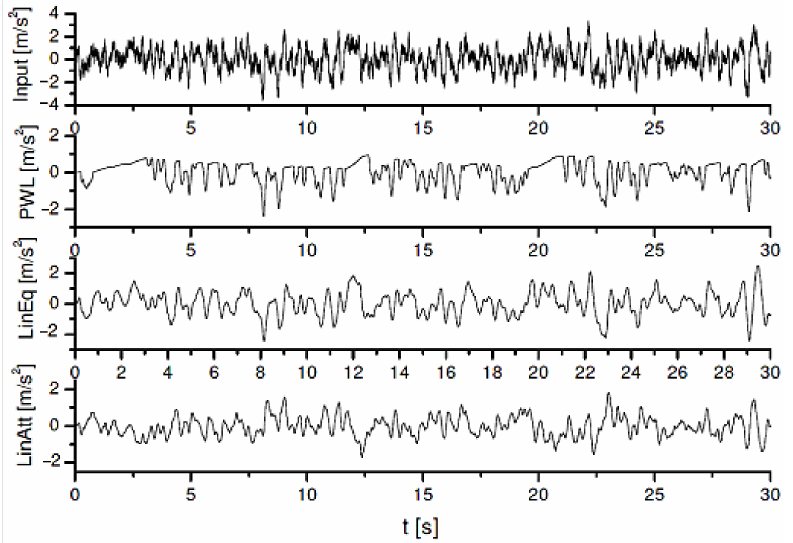
Figure 10. Acceleration output of PWL, equivalent linear and attached linear systems for case 1.